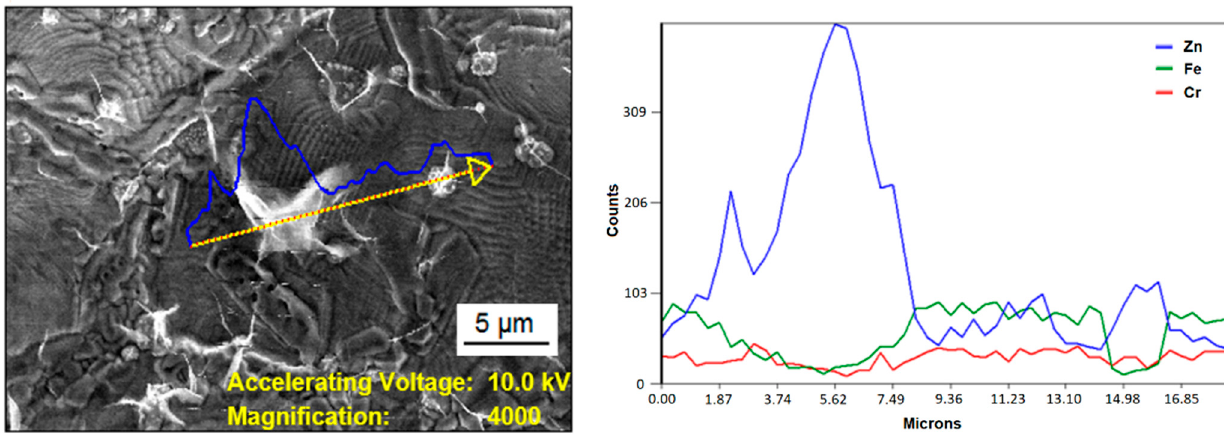
Figure 4. SEM-EDS line scan (along the yellow dashed line on the left image) chemical composition analysis (right image) inside a porous 440C stainless steel sample with 30 wt.% porosity and zinc acetate used as an electrolyte.